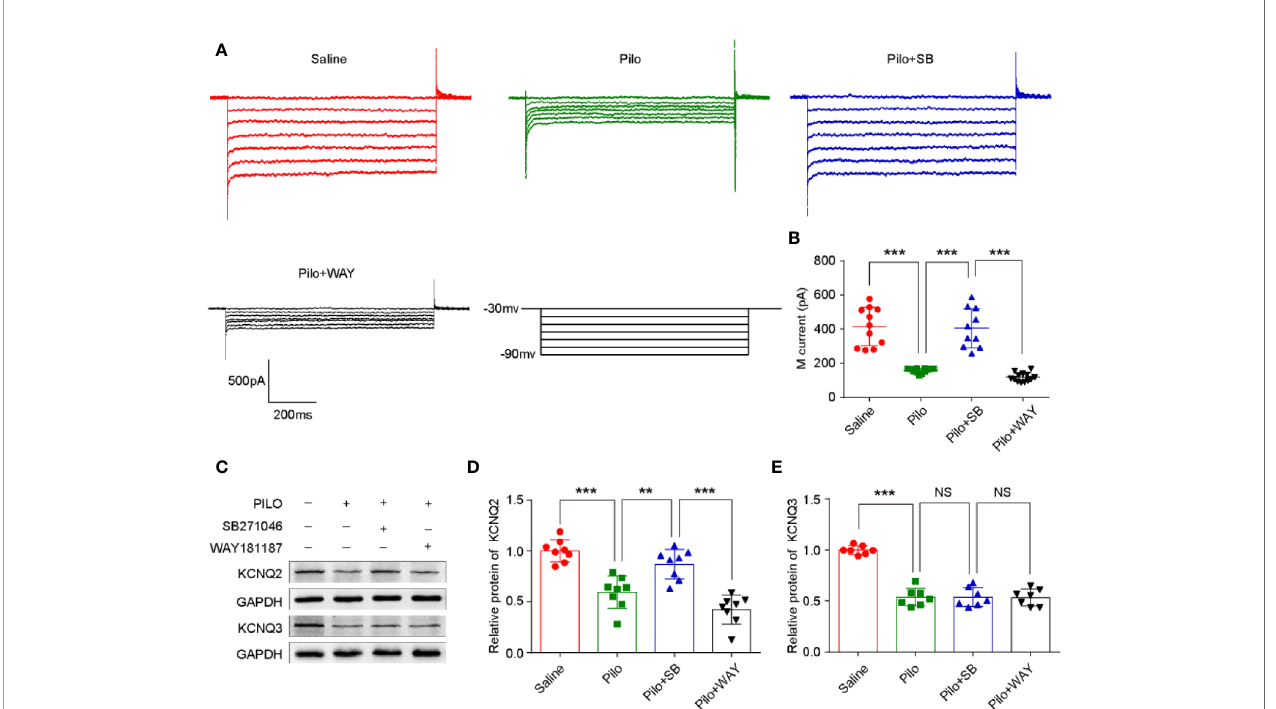
FIGURE 5 | SB271046 rescued aberrant hippocampal neuronal M-current in chronic epileptic rats. (A) Hippocampal neuronal M-currents were activated at different voltage steps. (B) Analysis of the mean amplitude of M-currents at -50 mV in the hippocampal neurons. The amplitude of M-currents in the Pilo group decreased signi fi cantly when compared with that of the Saline group. SB271046 rescued the aberrant M-currents while WAY181187 intervention did not. For comparing: ANOVA, F (3,42) = 47.139, p < 0.001; for the Saline group (n =1 1/5) vs. the Pilo group (n = 12/6): p < 0.001; for the Pilo group vs. the Pilo+SB group (n = 10/5), p < 0.001; for the Pilo+SB group vs. the Pilo+WAY (n=13/6), p < 0.001. Statistical comparisons were performed with a one-way analysis of variance (ANOVA, p < 0.05) followed by the Bonferroni post-hoc test (** p < 0.01, *** p < 0.001). (C) Representative Western blot images of KCNQ2/3 and GADPH. (D) Statistic analysis of KCNQ2 protein expression. SB271046 increased the level of KCNQ2 in pilocarpine-induced chronic epileptic hippocampus. Statistical comparisons were performed with one-way ANOVA followed by the Bonferroni post-hoc test (** p < 0.01, *** p < 0.001). For comparing: ANOVA, F (3,28) = 27.559, p < 0.001; for the Saline group vs. the Pilo group: p < 0.001; for the Pilo group vs. the Pilo+SB group, p = 0.0033; for the Pilo+SB group vs. the Pilo+WAY, p < 0.001, n = 4 for each group. (E) Statistic analysis of KCNQ3 protein expression. Neither SB271046 nor WAY181187 treatment affected the level of KCNQ3 in pilocarpine-induced chronic epileptic hippocampus. For comparing: ANOVA, F (3,24) = 60.669, p < 0.001; for the Saline group vs. the Pilo group: p < 0.001; for the Pilo group vs. the Pilo+SB group, p = 0.9541; for the Pilo+SB group vs. the Pilo+WAY, p = 0.9265. Statistical comparisons were performed with one-way ANOVA followed by the Bonferroni post-hoc test (** p < 0.01, *** p < 0.001 NS, not signi fi